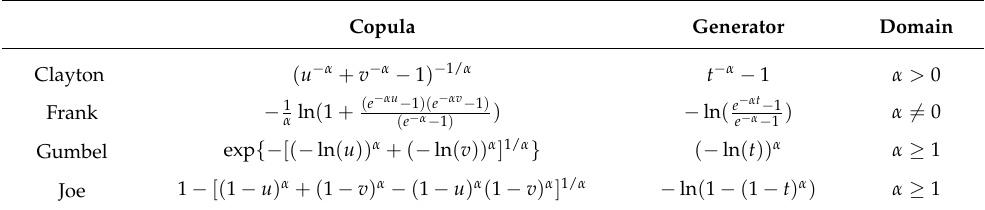
Table A1. Copula function, generator and domain for the Clayton, Frank, Gumbel and Joe Archimedean copulas.